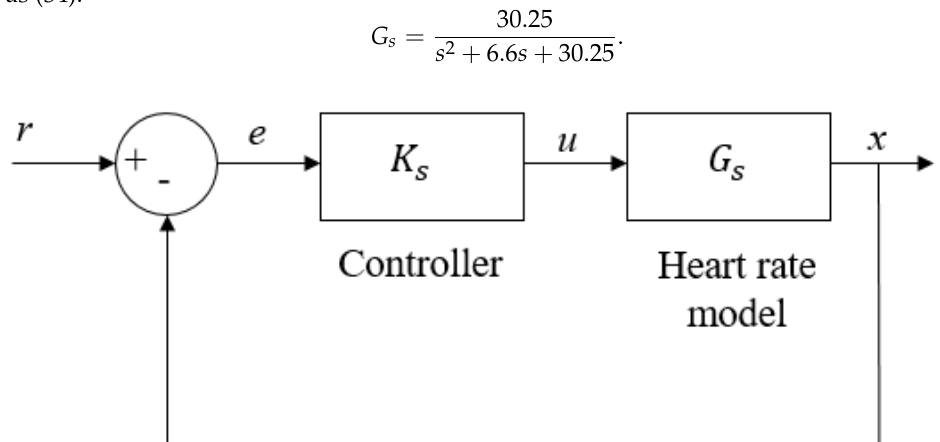
Figure 5. Simulink Block Diagram.